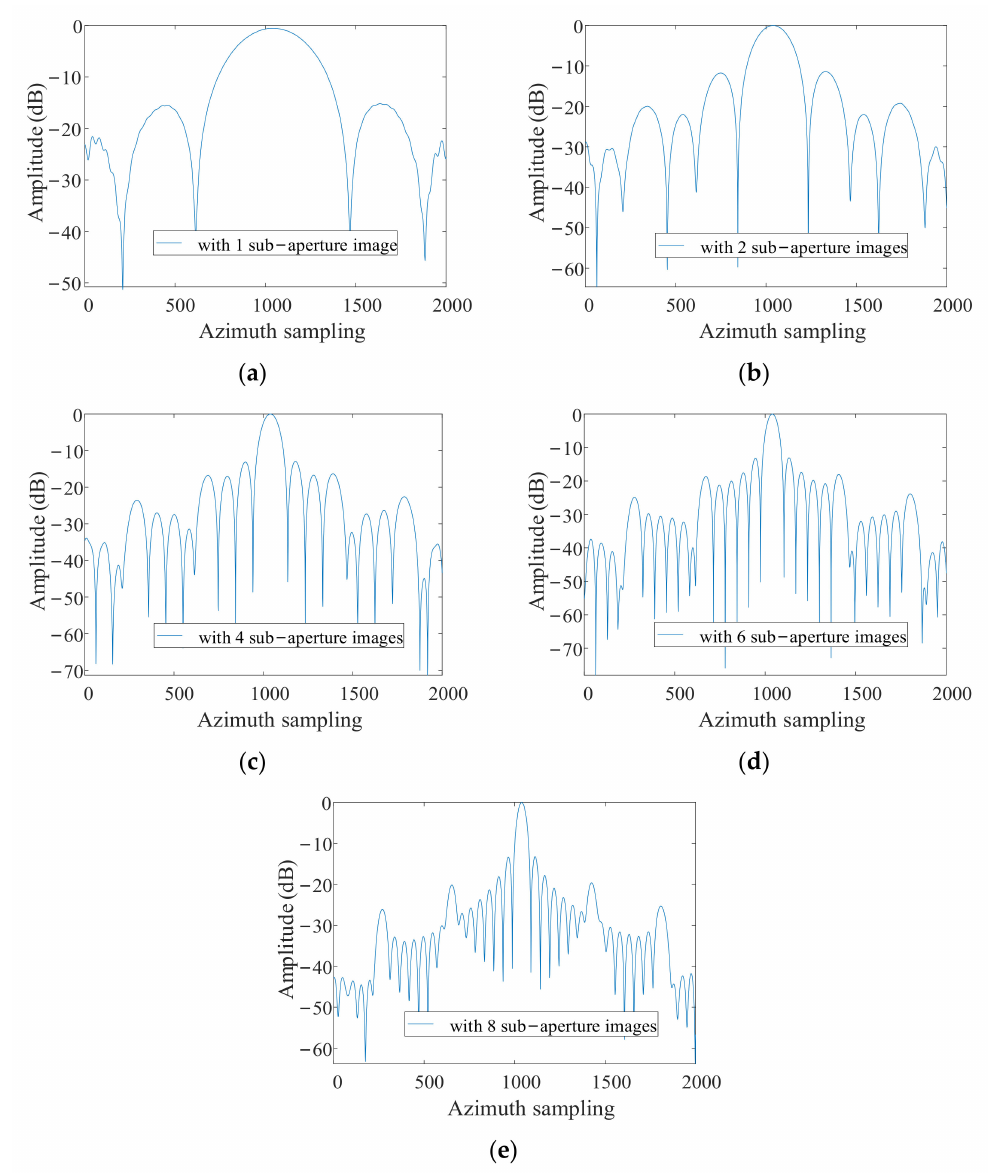
Figure 9. Azimuth profile of point target P 1 ( a ) with 1 sub-aperture image; ( b ) with 2 sub-aperture images; ( c ) with 4 sub-aperture images; ( d ) with 6 sub-aperture images; ( e ) with 8 sub-aperture images.